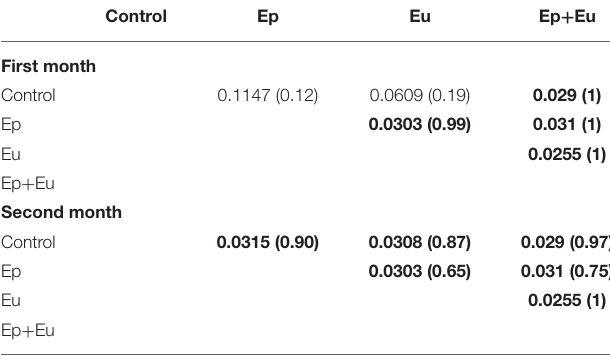
TABLE 5 | Results of ANOSIM analyses between PLFA compositions 2 months after Collembola re-inoculation of four treatments.